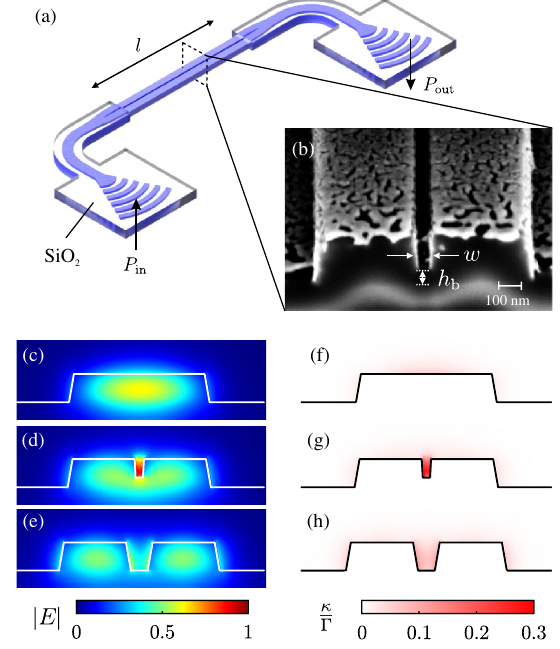
FIG. 1. Waveguide structure and mode profiles. (a) Schematic of the slot waveguides. The probe light P is coupled into the in waveguide via a grating coupler and guided to the slot section. The output P is detected with a photo multiplier tube. (b) FIB/ out SEM image of the waveguide cross section. The white patches are sputtered gold to prevent charge buildup during imaging. (c) – (e) Mode profiles of the fundamental TE mode for a closed (c), partially open (d), and fully open (e) slot waveguide. (f) – (h) Corresponding atomic decay rates κ into the fundamental mode normalized by the total decay rate Γ